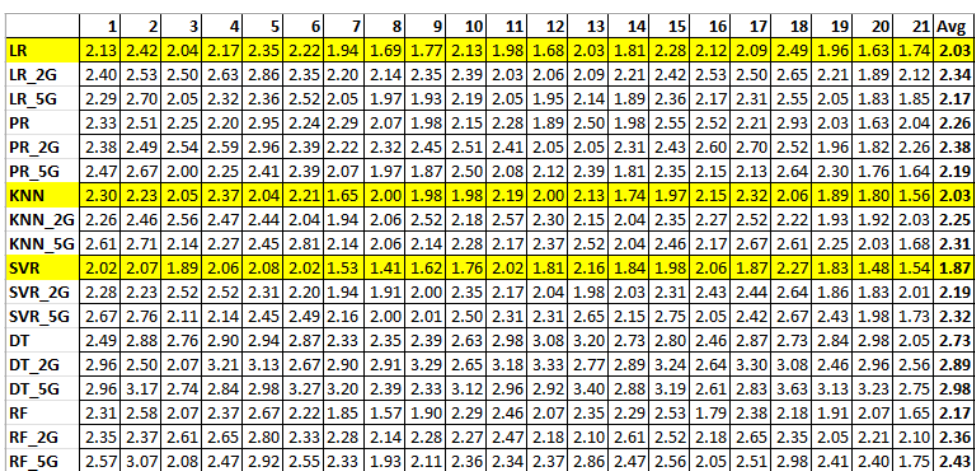
Figure 3. Average Distance Error (ADE) results for six algorithms for 21 runs.